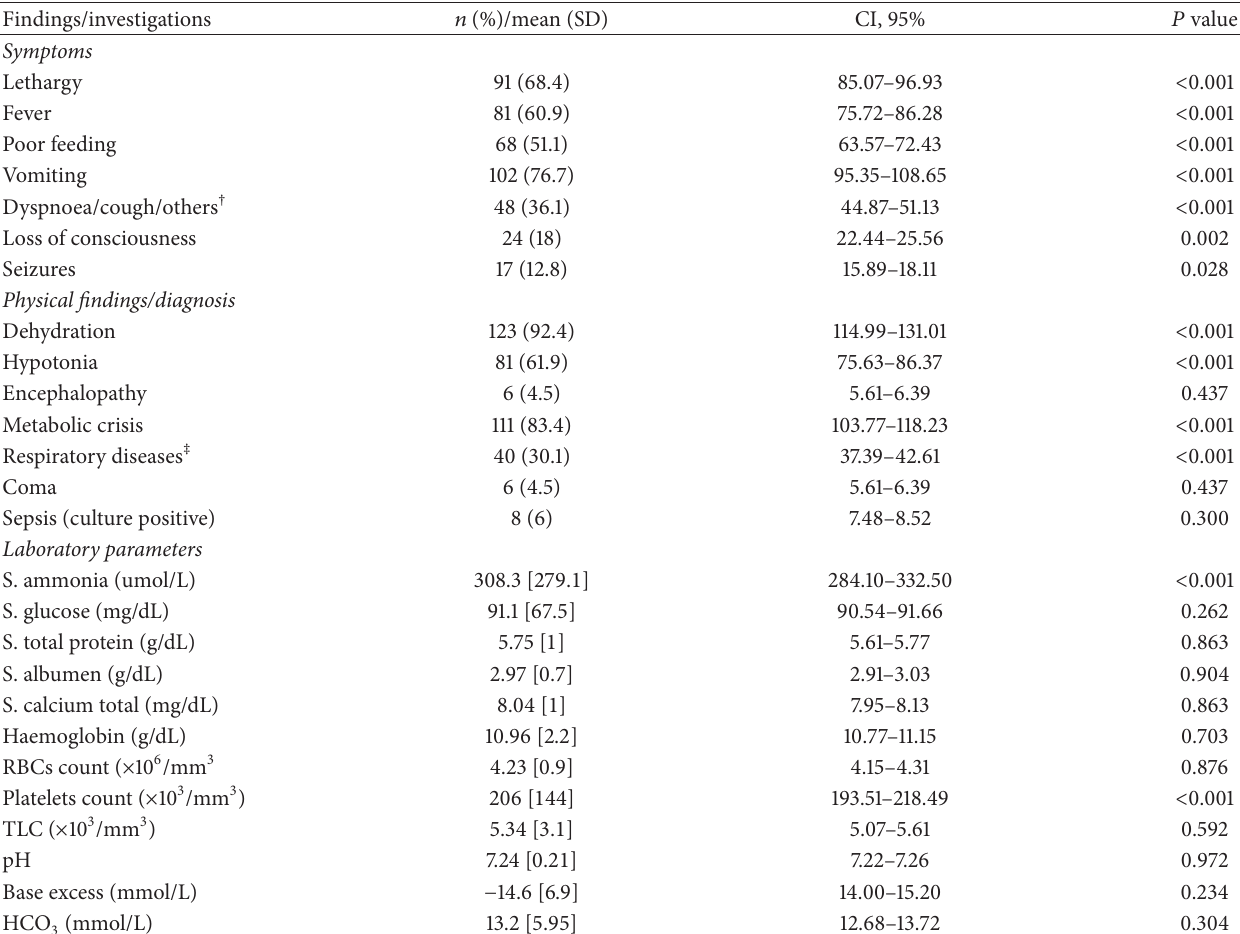
Table 3: Important clinical features and laboratory parameters on initial presentations in 𝑛 = 133 admissions of 26 patients with PA.